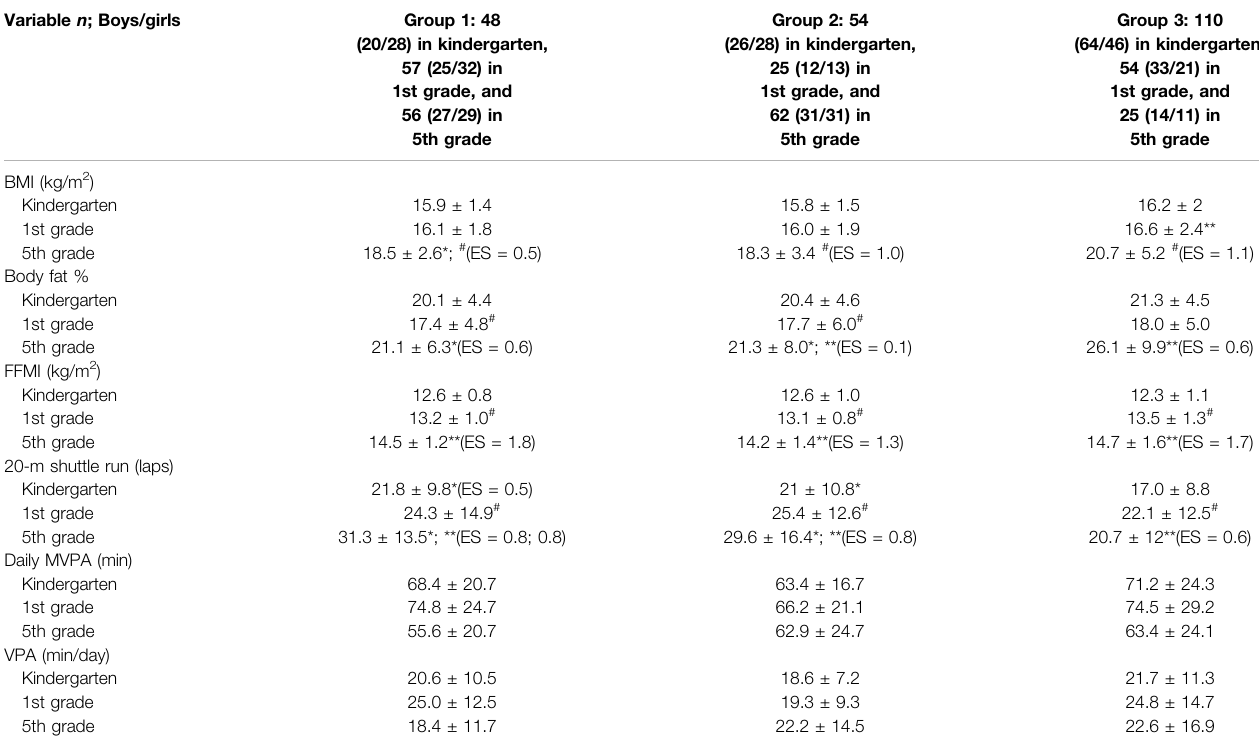
TABLE 1 | Body composition indices, 20-m shuttle run results, and physical activity of study participants in different groups according to age and organized sports participation. Variable n ;